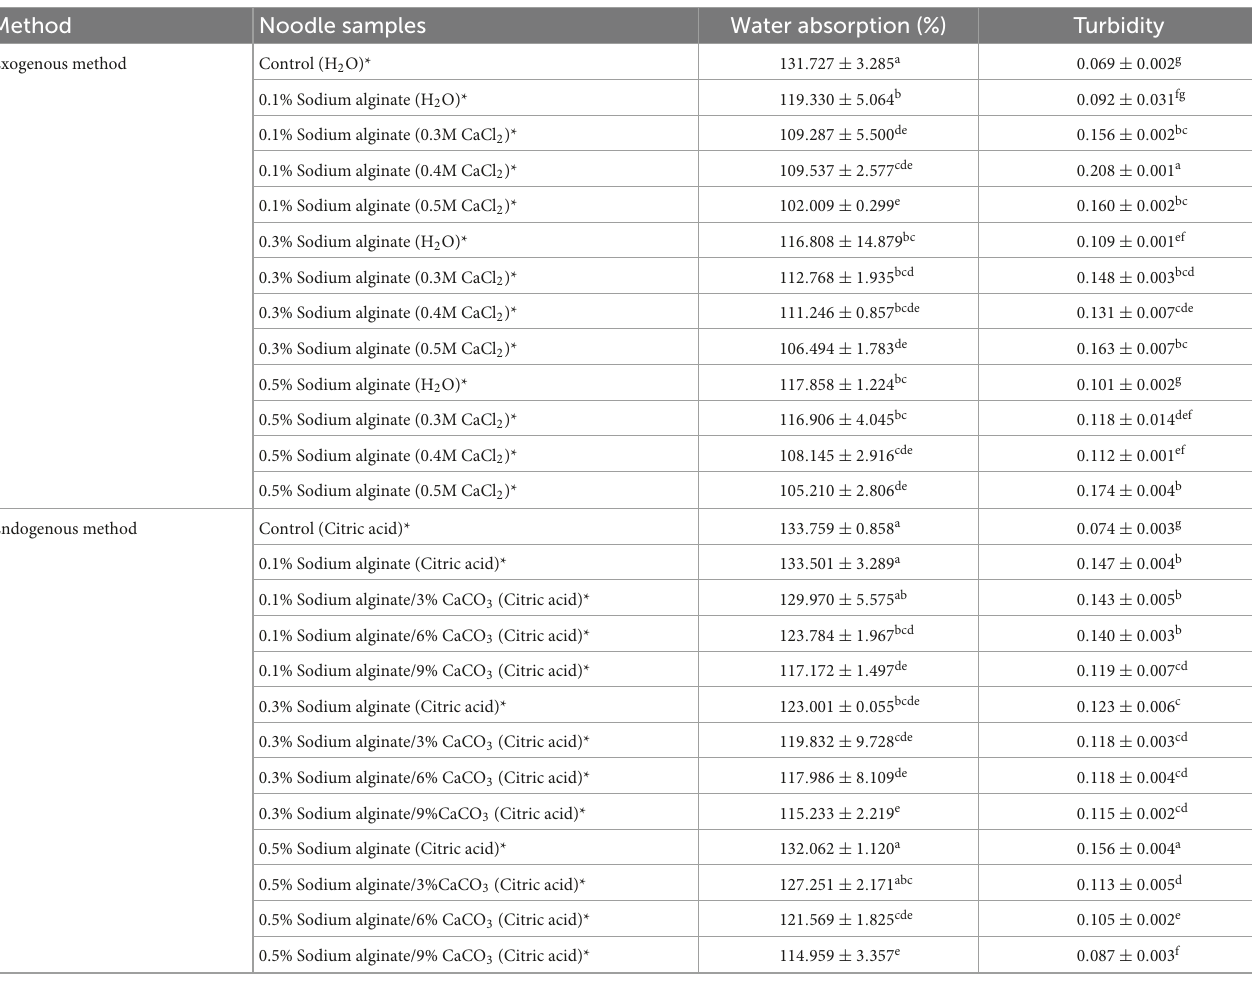
TABLE 1 Cooking characteristics of noodle